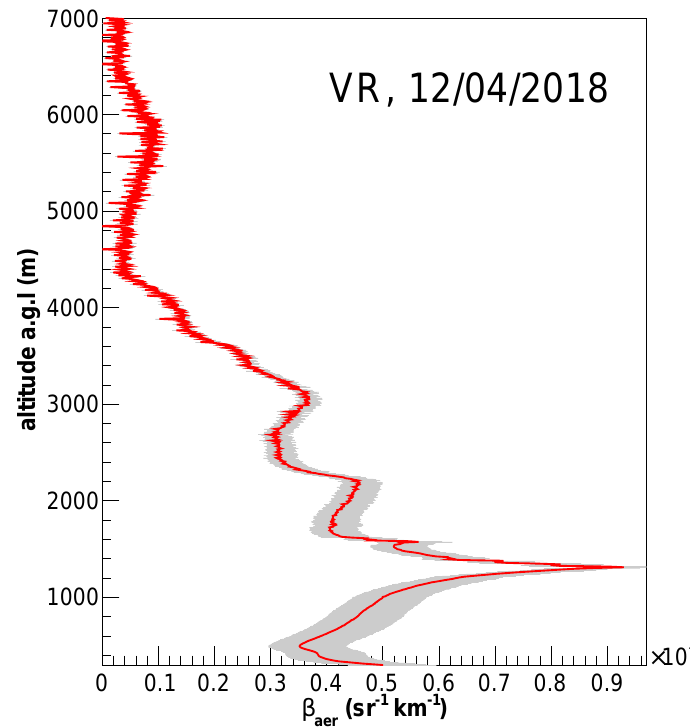
Figure 10. Daily average aerosol backscatter profile in Volta Redonda city on 4 December